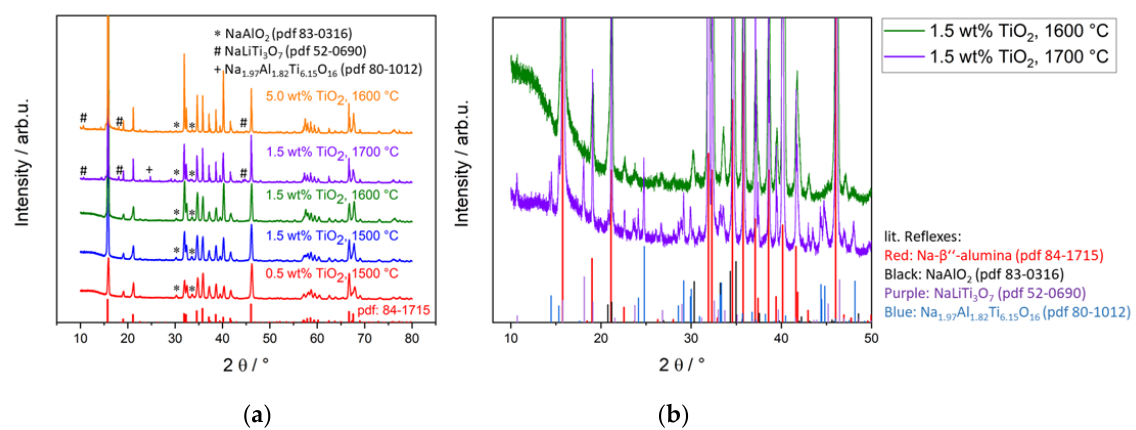
Figure 3. ( a ) Diffraction patterns of TiO 2 -doped Na- β″ -alumina samples. The reflex 006 (15.9°) is clipped off. The literature reflexes at the bottom are taken from pdf 84-1715. ( b ) XRD fingerprint of two TiO 2 -doped Na- β″ -alumina samples with Na- β″ -alumina literature reflexes at the bottom.